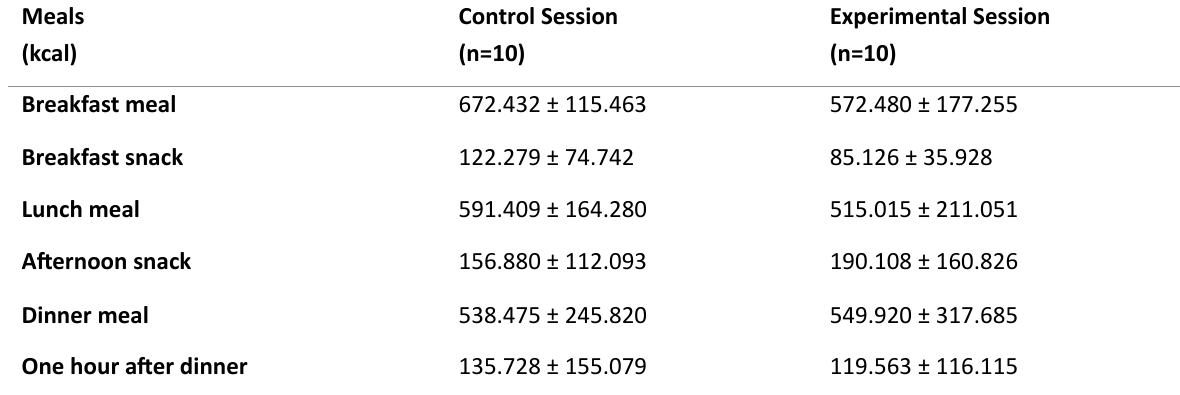
Table 2. Energy intake in the control and experimental session (Mean±SD) Meals